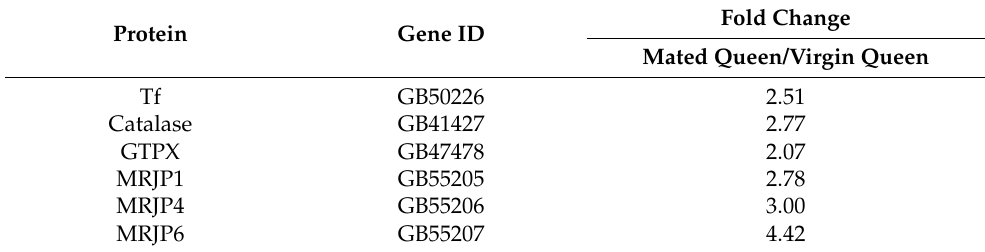
Antioxidant proteins and MRJPs differentially expressed in the spermathecae of mated queens.